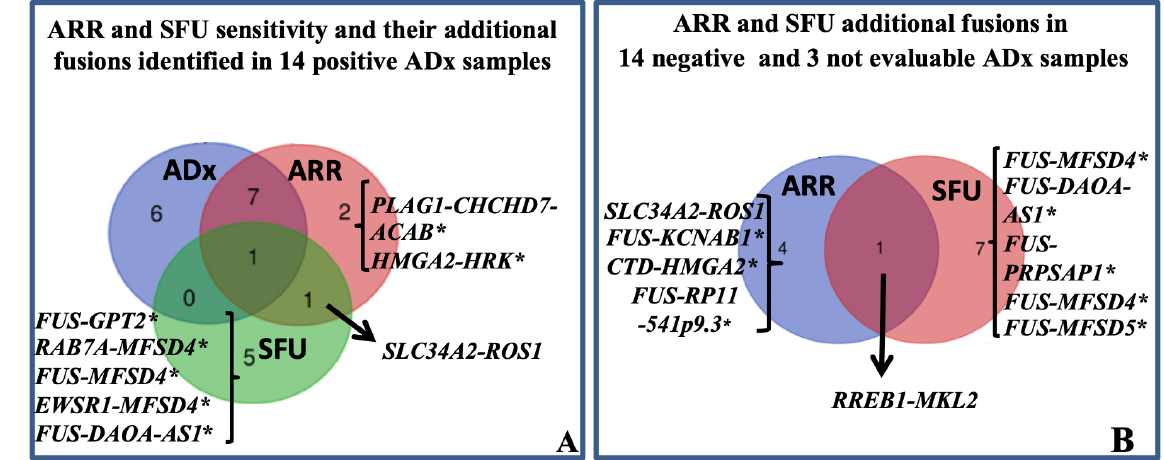
Figure 2. Sarcoma panel: ARR and SFU results. A: Venn diagram showing ARR and SFU sensitivity. The sensitivity was evaluated assuming that the 14 fusions identified by ADx were true positive. The fusion SLC34A2-ROS1 was identified in sample 3 (Table 1 ) also harboring the EWSR1-TFCP2 translocation. B: Venn diagram showing the additional fusions identified by ARR and SFU in 14 negative and 3 not evaluable ADx cases. With the exception of SLC34A2-ROS1 and ras responsive element binding protein 1 ( RREB1 )- MKL2 , all the others translocations marked by * are unknown/unpublished. CHCHD7 : coiled-coil-helix-coiled-coil-helix domain containing 7; HRK : harakiri, BCL2 interacting protein; GPT2 : glutamic-pyruvic transaminase 2; RAB7A : RAB7A, member RAS oncogene family; MFSD4 : major facilitator superfamily domain containing 4; DAOA-AS1 : D-amino acid oxidase activator antisense RNA 1; PRPSAP1 : phosphoribosyl pyrophosphate synthetase associated protein 1; ACAB : acetyl-CoA carboxylase beta; KCNAB1 : potassium voltage-gated channel subfamily A regulatory beta subunit 1; CTD : Coats disease; RP11 : retinitis pigmentosa